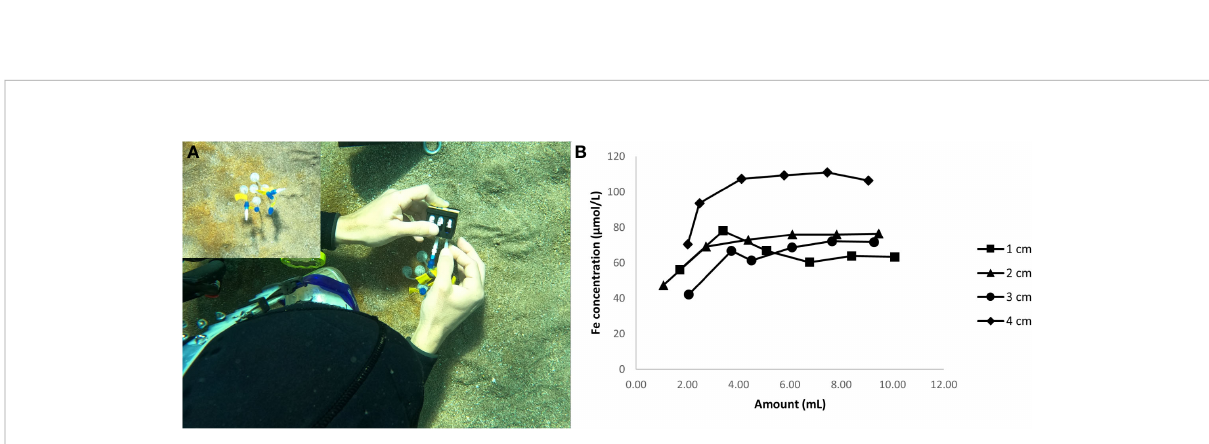
FIGURE 5 (A) Photographs taken by the authors showing the collection of pore water from one of the red patch using different Rhizons representing different depths in 2 mL vials, (B) Fe concentration in the pore water as function of the volume of porewater collected through Rhizons from different